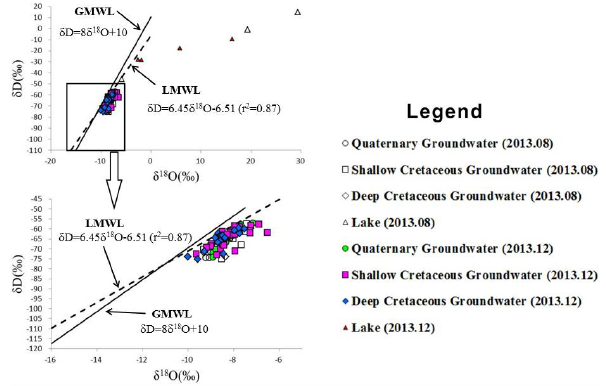
Figure 7. Relationship between hydrogen and oxygen isotopes in groundwater and lake water in August and December